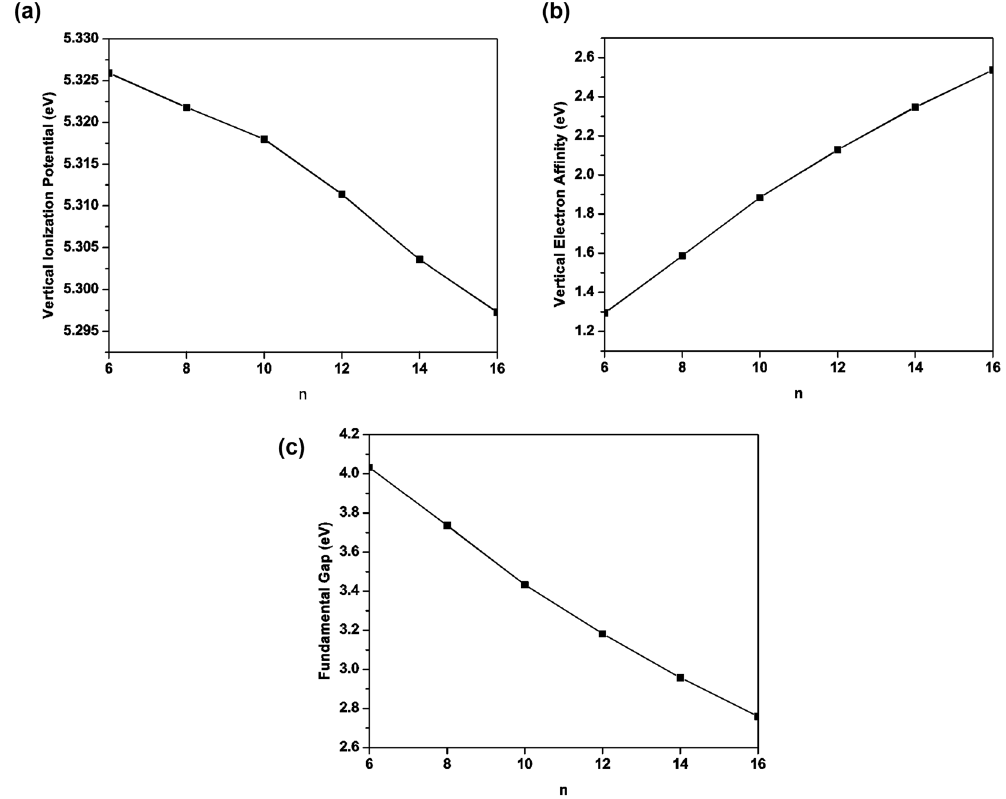
Figure 4. ( a ) Vertical ionization potential, ( b ) vertical electron affinity, and ( c ) fundamental gap for the ground state of Li 2 B n , obtained with